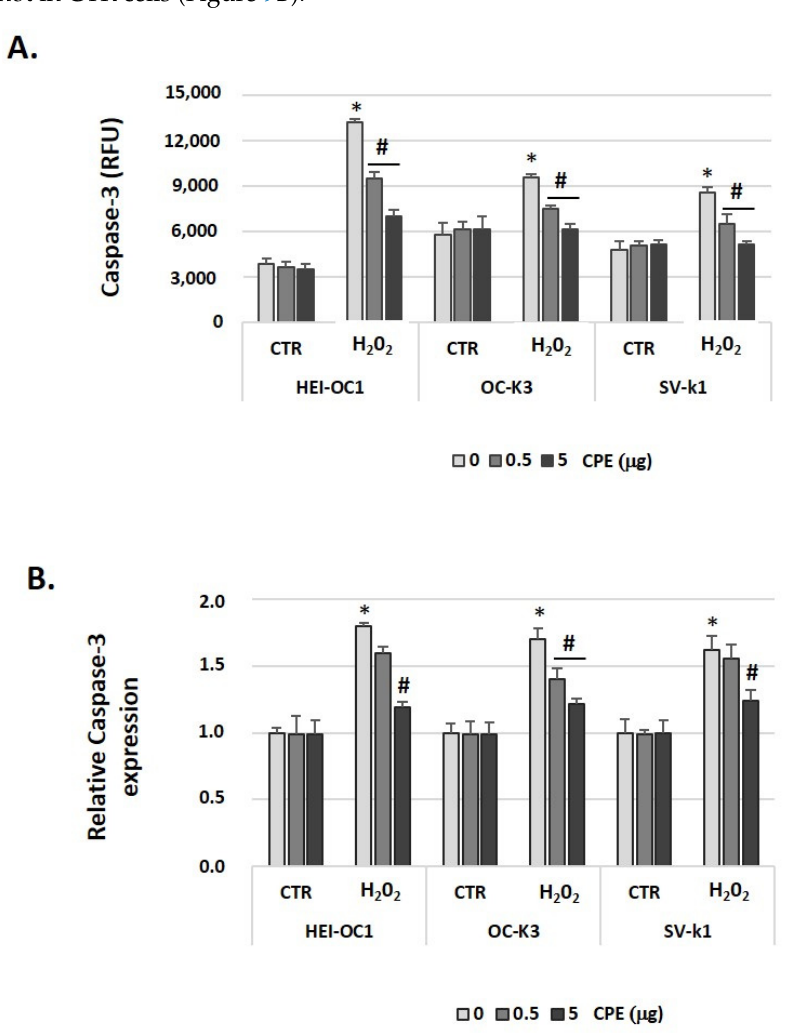
Figure 9. Cocoa reduced the gene expression of caspase-3 in senescence auditory cells . ( A